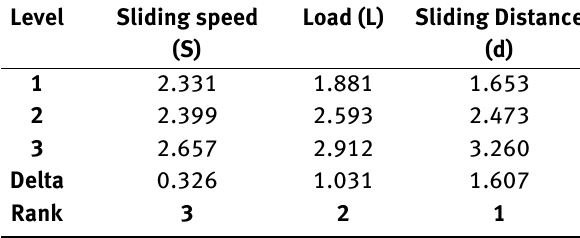
Table 7: Response table for means for base alloy (Al2219)